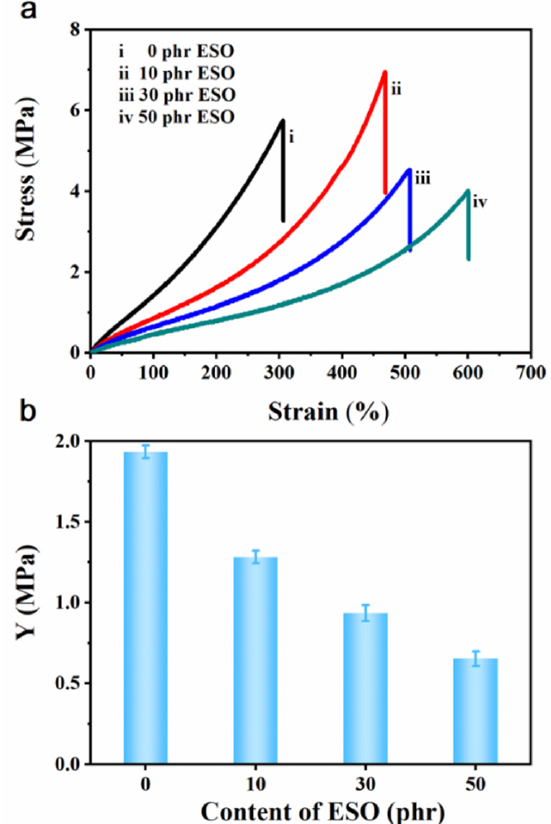
Figure 8. ( a ) Stress–strain curves of Si747@BTO/ENR composites with various loadings of ESO: (i) 0 phr, (ii) 10 phr, (iii) 30 phr, and (iv) 50 phr. ( b ) Y of 10 phr Si747@BTO/ENR composites with various loadings of ESO.